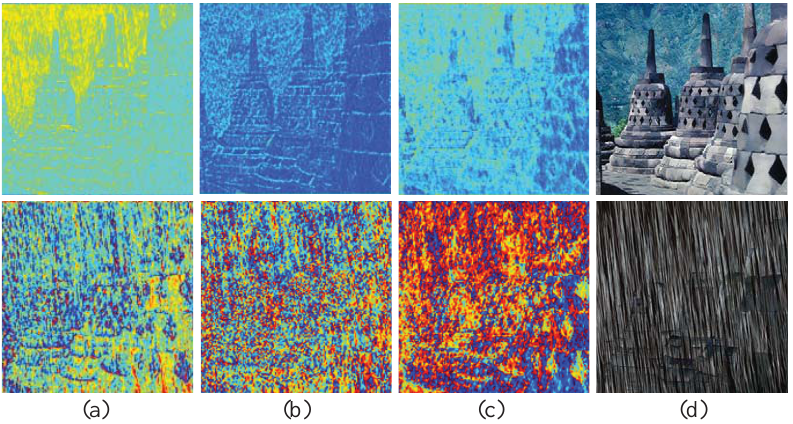
Figure 6. The feature visualization of the rain-free layer (the first row) and rain streak (the second row) from ( a ) 1st HMM, ( b ) 4th HMM, ( c ) 7th HMM, ( d ) output of CR